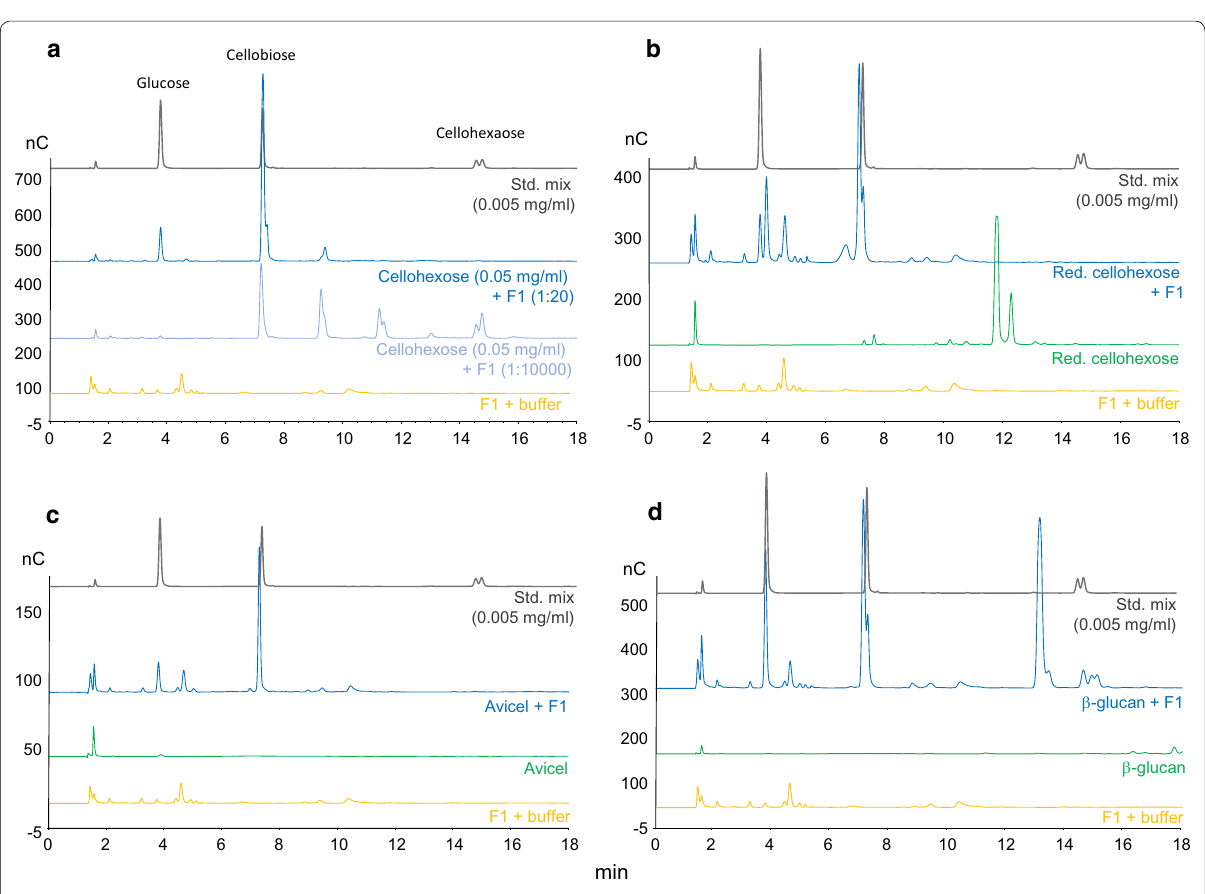
Fig. 7 Results from ICS analysis of degradation products using enzyme F1 on different substrates. In all cases, reactions were performed in a 1 ml volume containing 50 µl F1 enzyme, i.e. 1:20. A standard mixture (std mix) applied gives peaks for cellohexaose, cellobiose and glucose, indicated in panel: a Cellohexaose used as reaction substrates, with 50 µl (1:20) or 0.1 µl (1:10,000) F1 enzyme. Intermediate product peaks detected in low enzyme amount reaction, from right to left pentamer, tetramer, trimer followed by cellobiose and glucose. b Reduced cellohexaose used as reac- tion substrate. c Avicel used as reaction substrate (reaction products diluted 1:10 prior to analysis by ICS). d β-glucan used as reaction substrate. For the full chromatogram of β-glucan w/wo F1 added, please refer to Additional file 1: Figure